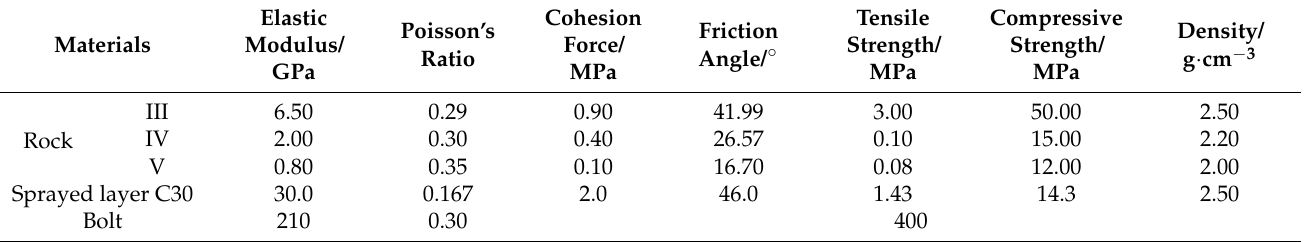
Table 1. Physical and mechanical parameters of materials.